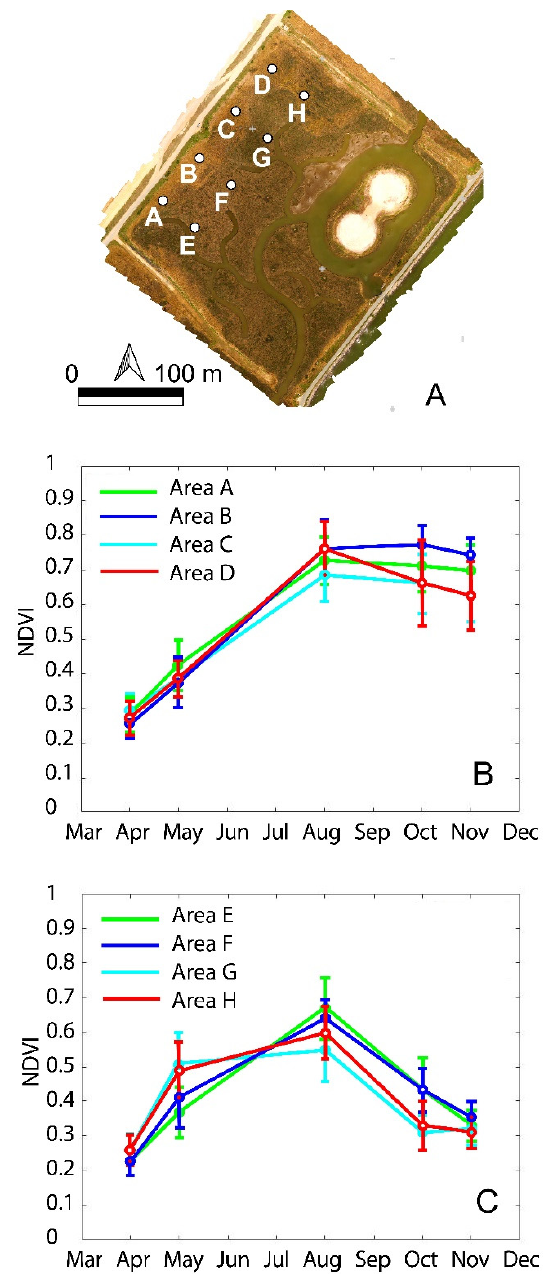
Figure 9. ( A ) Position of the 8 areas of 4 m 2 . Areas A-B-C-D refer to S. pumilus , while E-F-G-H refer to S. alterniflora (orthophoto from RGB camera in May 2019). ( B ) Seasonal NDVI changes in the S. pumilus . ( C ) Seasonal NDVI changes in the S. alterniflora . The error bar refers to above and below a standard